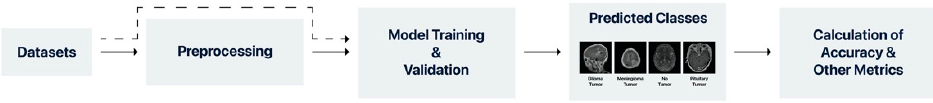
Figure 1. Training diagram of the models.